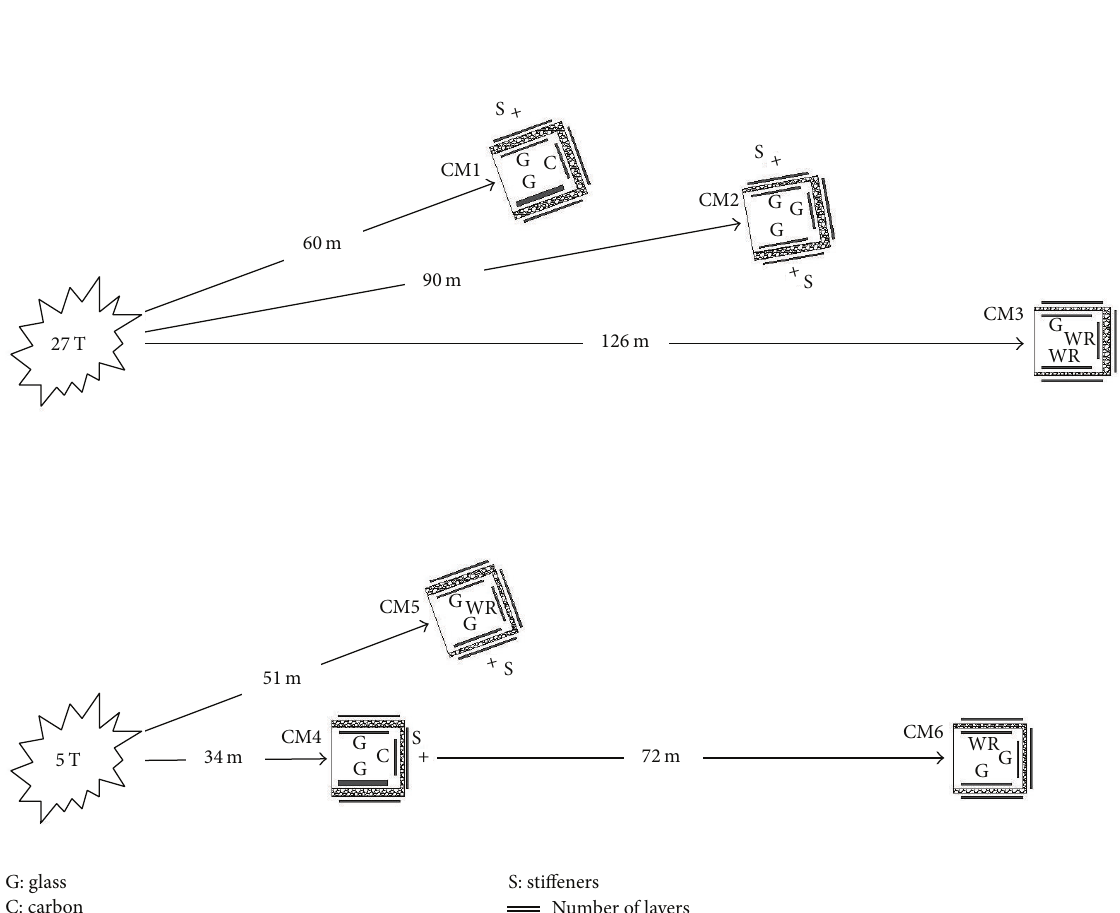
Figure 1: Tan and Patoary’s [6] test